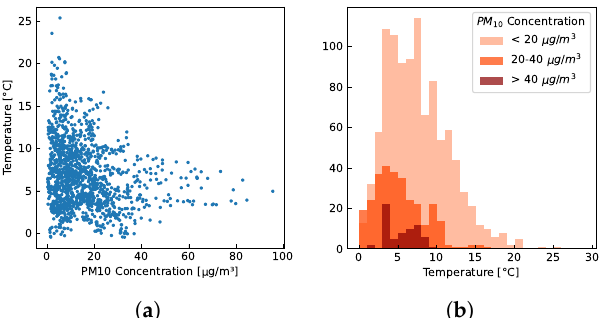
Figure 8. Hourly mean values recorded with sensor-box 1 between 15 October 2021 and 23 December 2021 in Stans, Nidwalden. ( a ) PM 10 concentration vs. temperature; ( b ) Distribution of three different PM 10 concentration